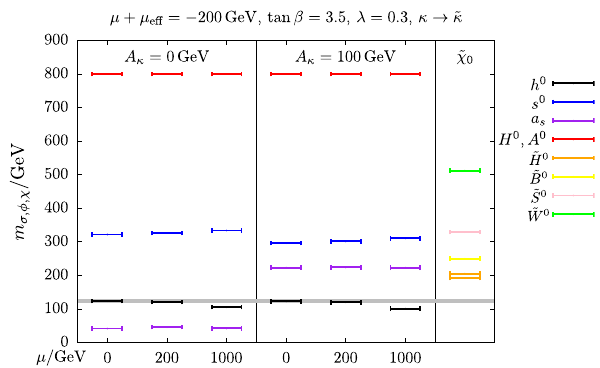
Fig. 3 In a similar manner as in Fig.2, the spectra of Higgs bosons and neutralinos are shown in the μ NMSSM. The neutralino masses are invariant under changes in μ by identifying the sum (μ + μ eff ) of the μ NMSSM with the μ eff term of the NMSSM, and by rescaling κ according to Eq. (36). We set κ = 0 . 8 λ , and for μ = 0GeV we assign μ eff = − 200GeV. The Higgs mass spectra are slightly affected by the